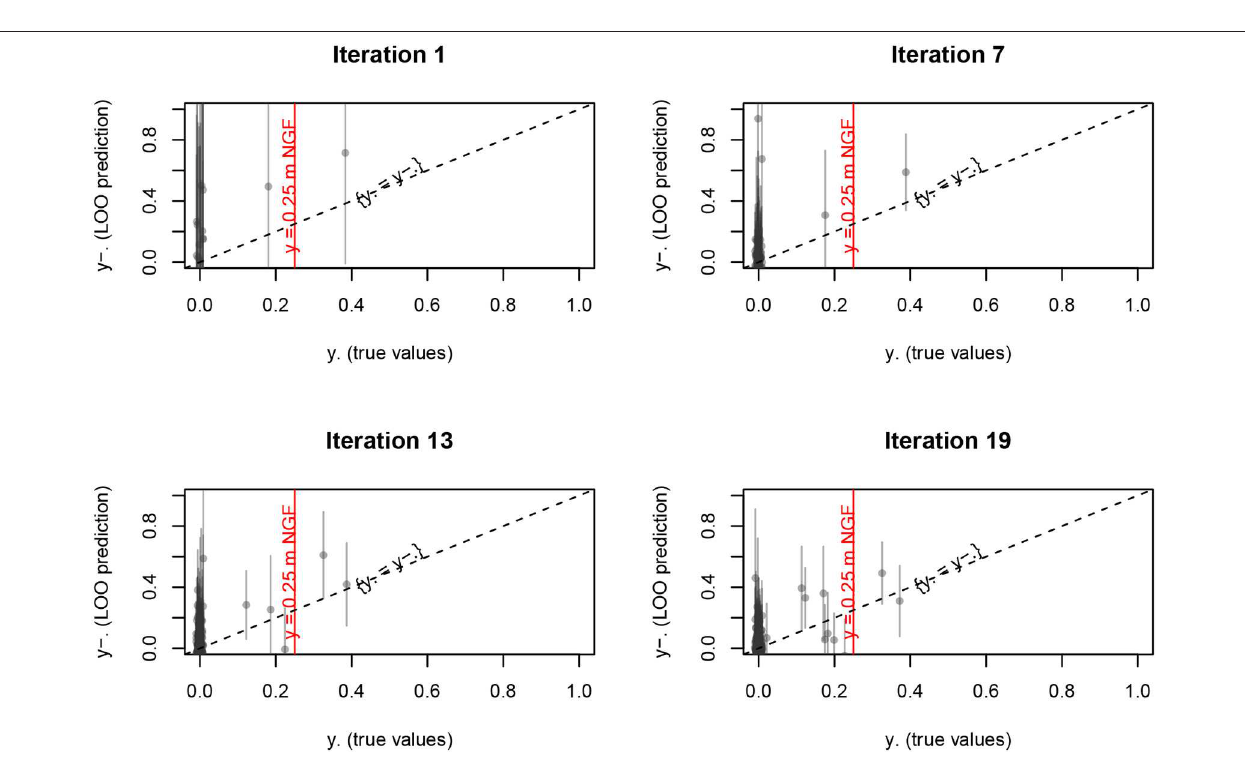
FIGURE 11 | Kriging prediction of max t ( H p 1 ) vs. the true values at iteration 1, 7, 13, and